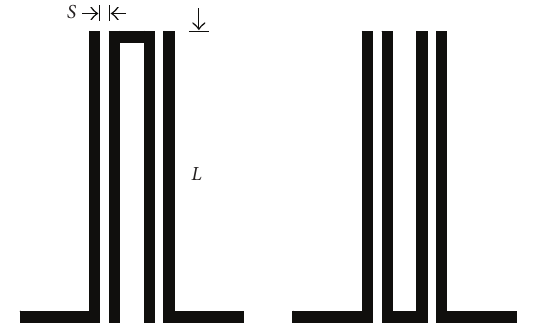
Figure 12: Single hair-pin resonator filter having two orientations with parallel coupled-feed lines.